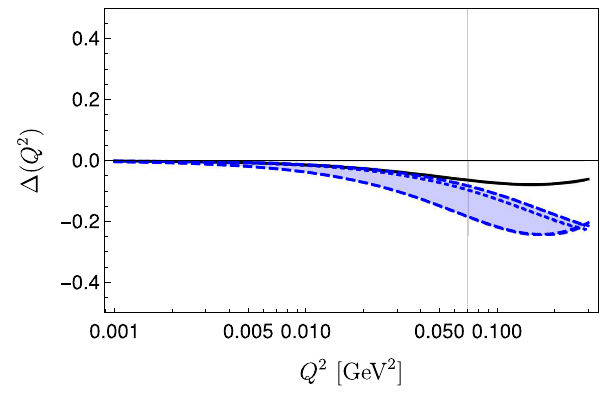
Fig. 11 The function Eq. (45) evaluated with the original model. The bandstandsfortheresultsobtainedbyvarying κ :0 . 35 ≤ κ ≤ 0 .